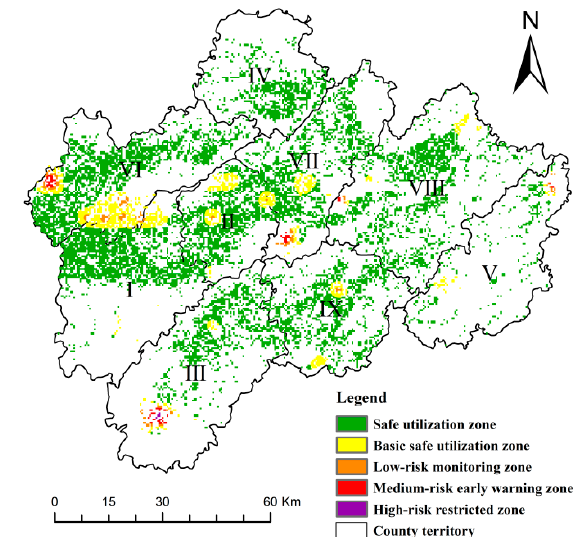
Figure 4. Safe utilization zoning of soil heavy metals in farmland area of Jinhua City. I: Wucheng District; II: Jindong District; III: Wuyi County; IV: Pujiang County; V: Pan’an County; VI: Lanxi City; VII: Yiwu City; VIII: Dongyang City; IX: Yongkang City. Table 4. Area statistics of each utilization area of farmland soil of Jinhua City. Grade Area (km 2 ) Proportion (%) Safe utilization zone 2144.47 89.35 Basic safe utilization zone 206.08